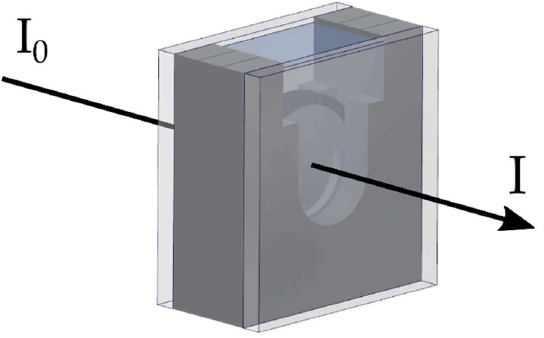
Figure 2. Schematic of the incident and transmitted light intensity through the cuvette. The incident light falls perpendicular to the plane of the scaffold and thus perpendicular to the fiber axis. The cuvette was filled with either ethanol (EtOH) or phosphate-buffered saline (PBS).